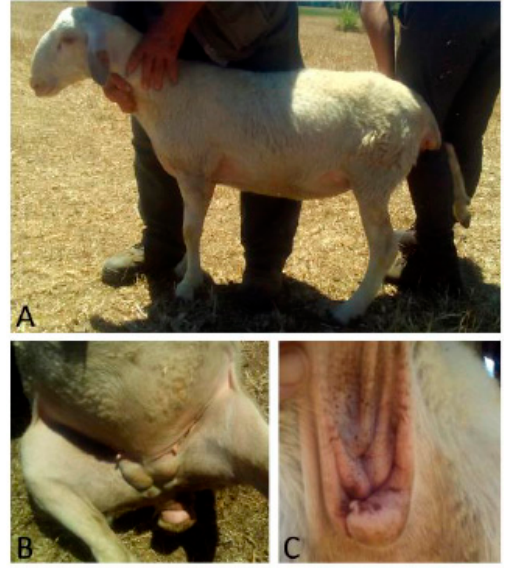
Figure 2. Case 2. ( A ) Montonino profile of the head; ( B ) two masses in the mammary region; ( C ) Figure 2. Case2. ( A )Montoninoprofileofthehead; ( B )twomassesinthemammaryregion; ( C )abnormal abnormal vulva.